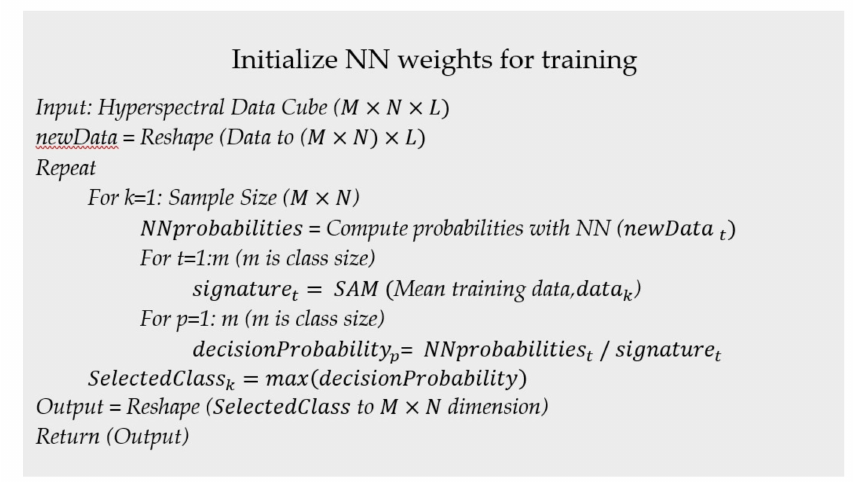
Figure 6. Pseudo-code of the followed